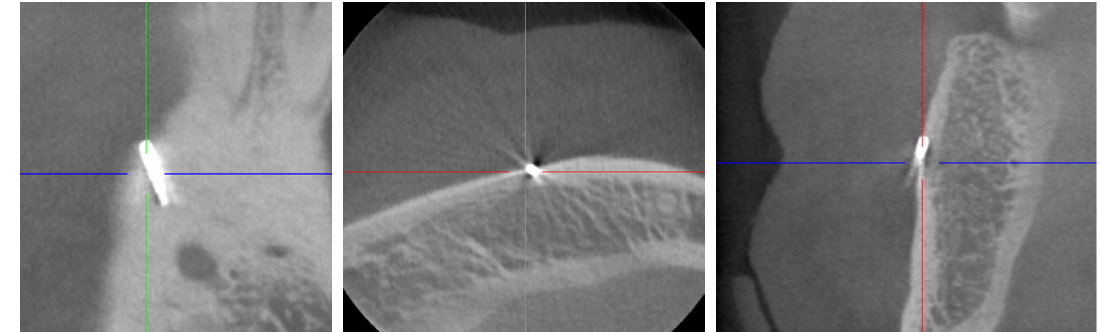
Figure 2. Cone-beam tomography showing the metallic opacity compatible with a broken tip of a periodontal probe. No close relationship to the mental nerve canal or supplying vessels was